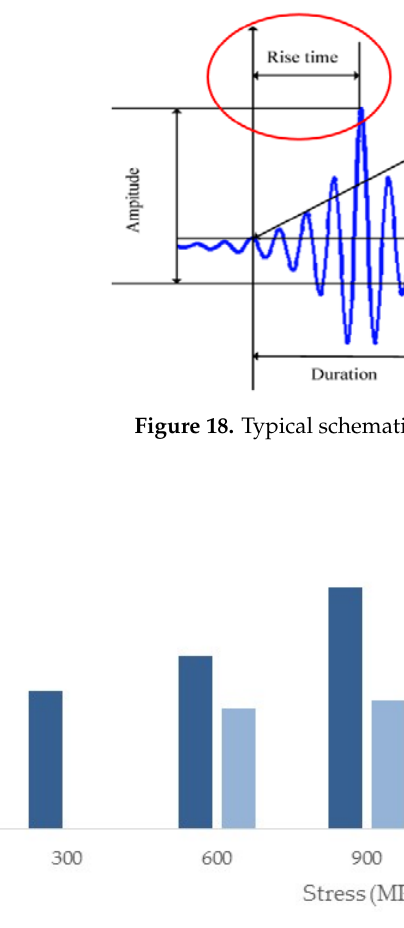
Figure 19. Evolution of average rise time values for the angle-ply laminates.